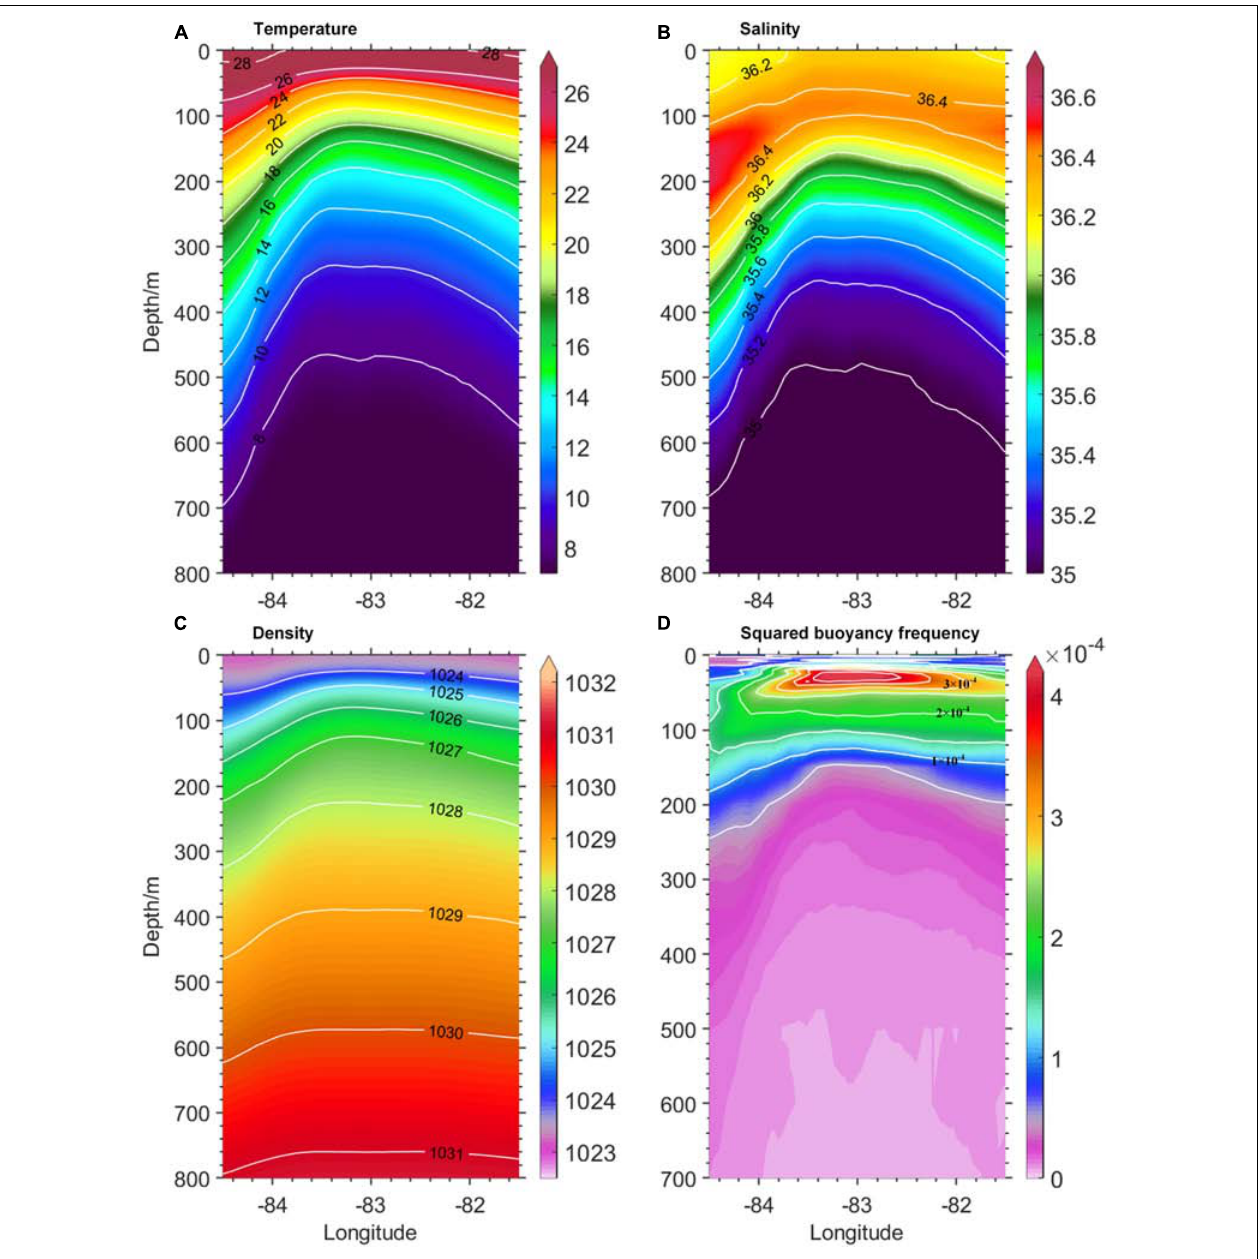
FIGURE 9 | Vertical distributions of mean simulated water temperature ( A , unit: ◦ C), salinity ( B , unit: psu), density ( C , unit: kg/m 3 ), and the squared buoyancy frequency ( D , unit: s − 2 ) along a zonal section (annotated with a magenta line in Figure 6B ) from April 23 to July 15, 2017, during which the TE remained quasi-stationary off the